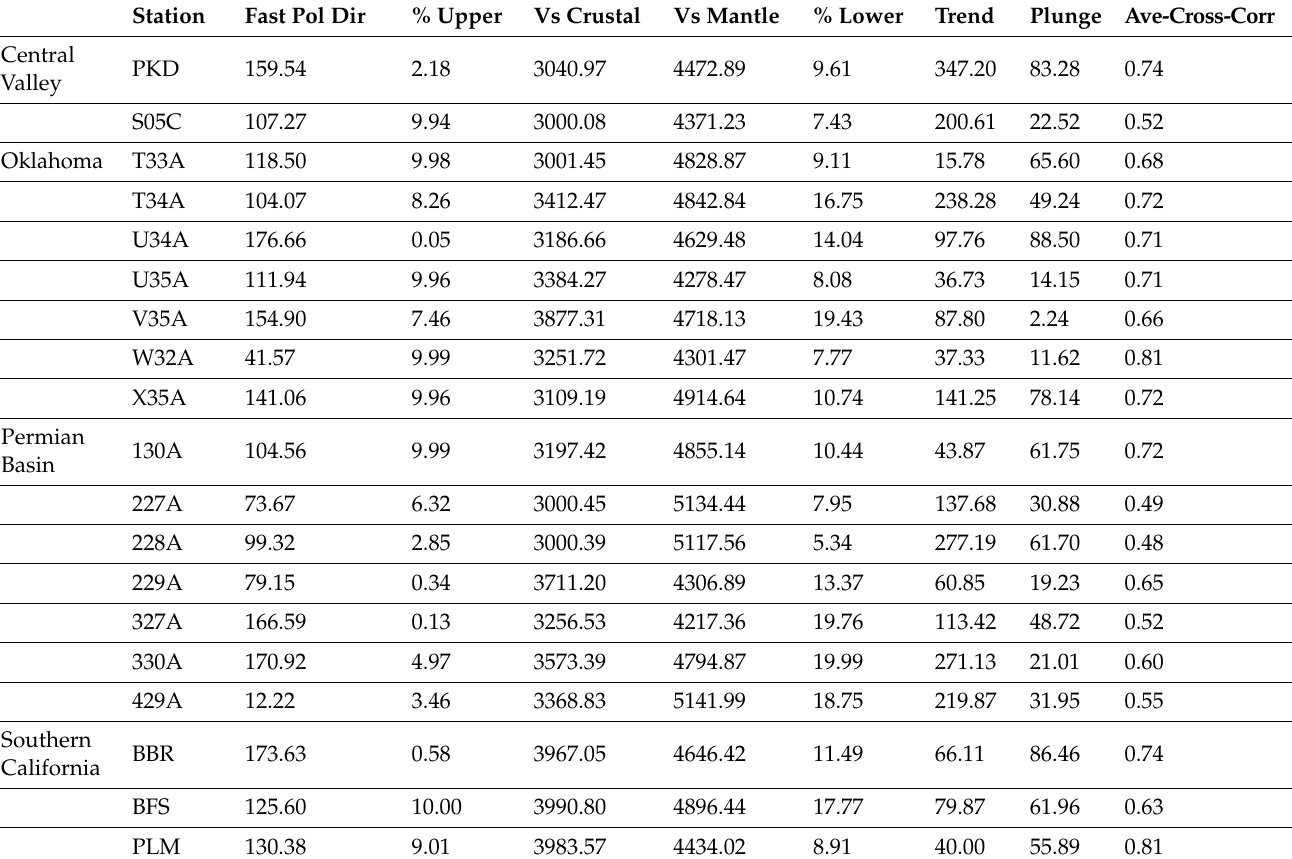
Table 4. Full results from the best-fitting model for each of the twenty